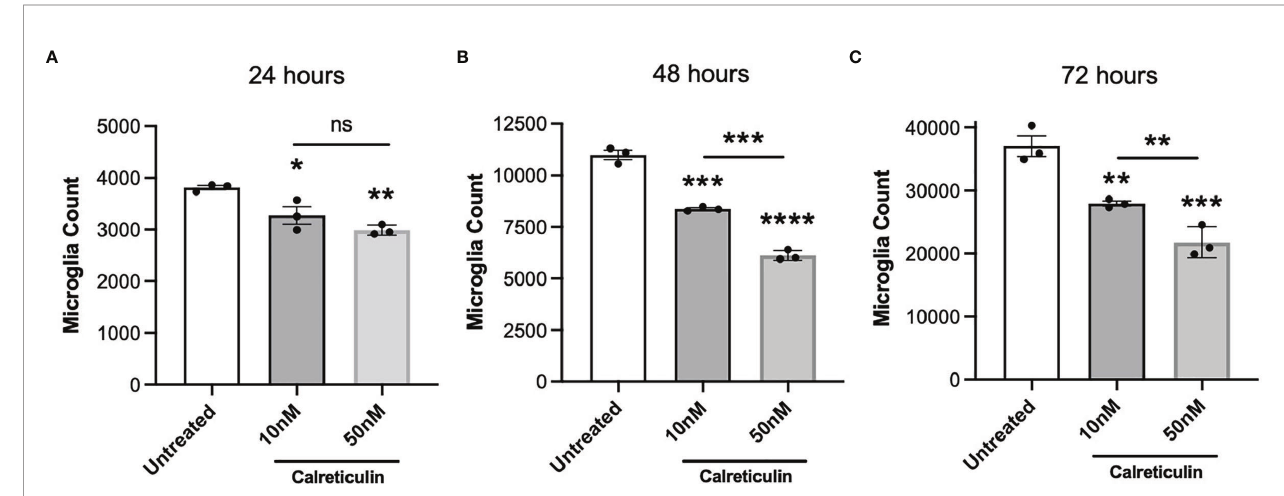
FIGURE 5 | Calreticulin dose-dependently inhibits the proliferation of BV-2 microglia. BV-2 were seeded at a density of 2000 cells/well, then treated with either 0, 10 or 50 nM calreticulin. After incubations for 24 hours (A) , 48 hours (B) or 72 hours (C) , microglia were stained with Hoechst 33342 and microglial cell numbers were quanti fi ed by fl uorescence microscopy. Data presented as mean microglial cell numbers, with error bars representing the SEM of 3 independent experiments. Statistical comparisons were made to the untreated control, or as illustrated by a comparison line, by one-way ANOVA. ns: p ≥ 0.05, *p<0.05, **p<0.01, ***p<0.001,